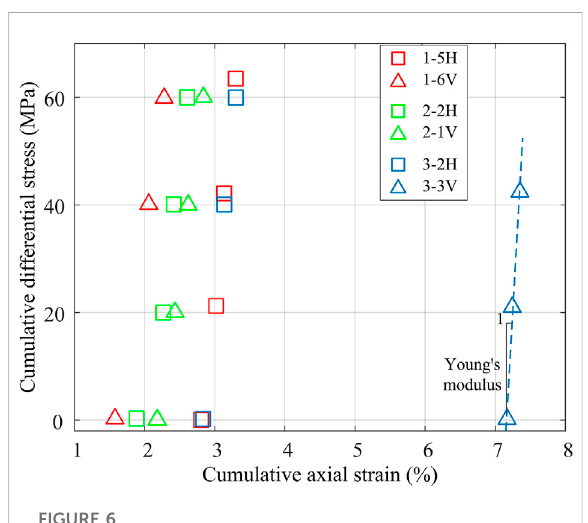
FIGURE 6 Relationship of the cumulative differential stress and total axial strain for three pairs of shale samples. Each pair of samples were retrieved from the same